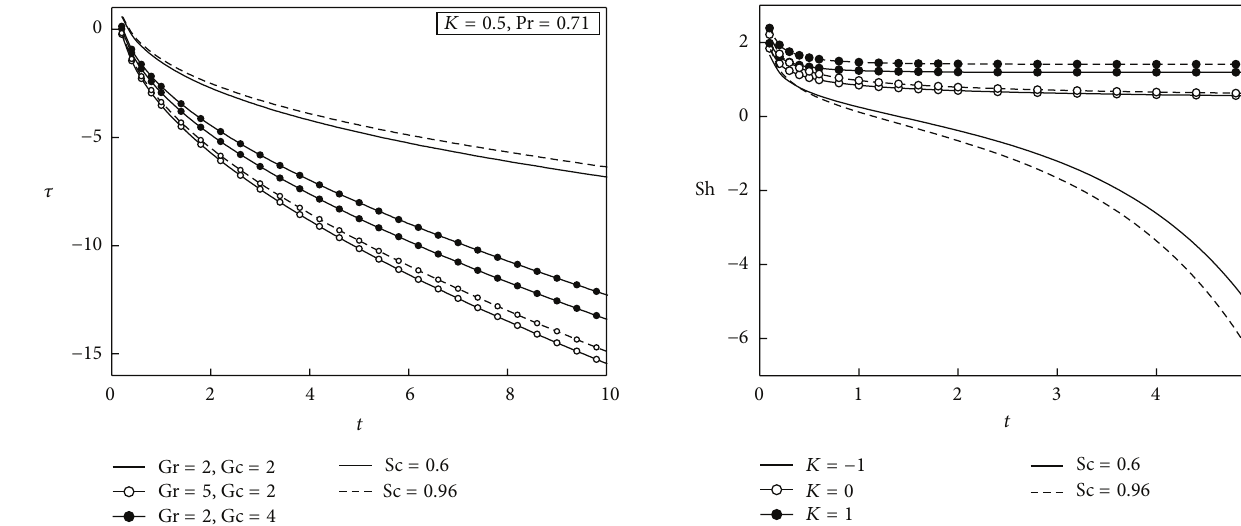
Figure 10: Effects of Gr and Gc on skin friction at 𝐾 = 0.5 , Pr = 0.71, and Sc = 0.6 and 0.96.